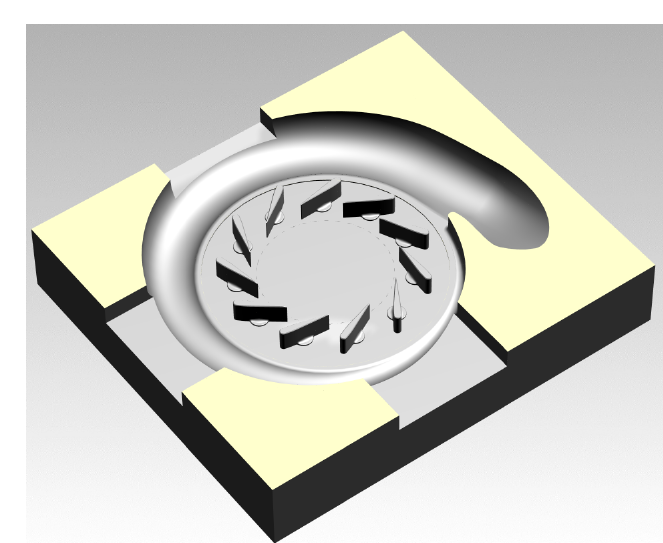
Figure 14. Access PIV view.